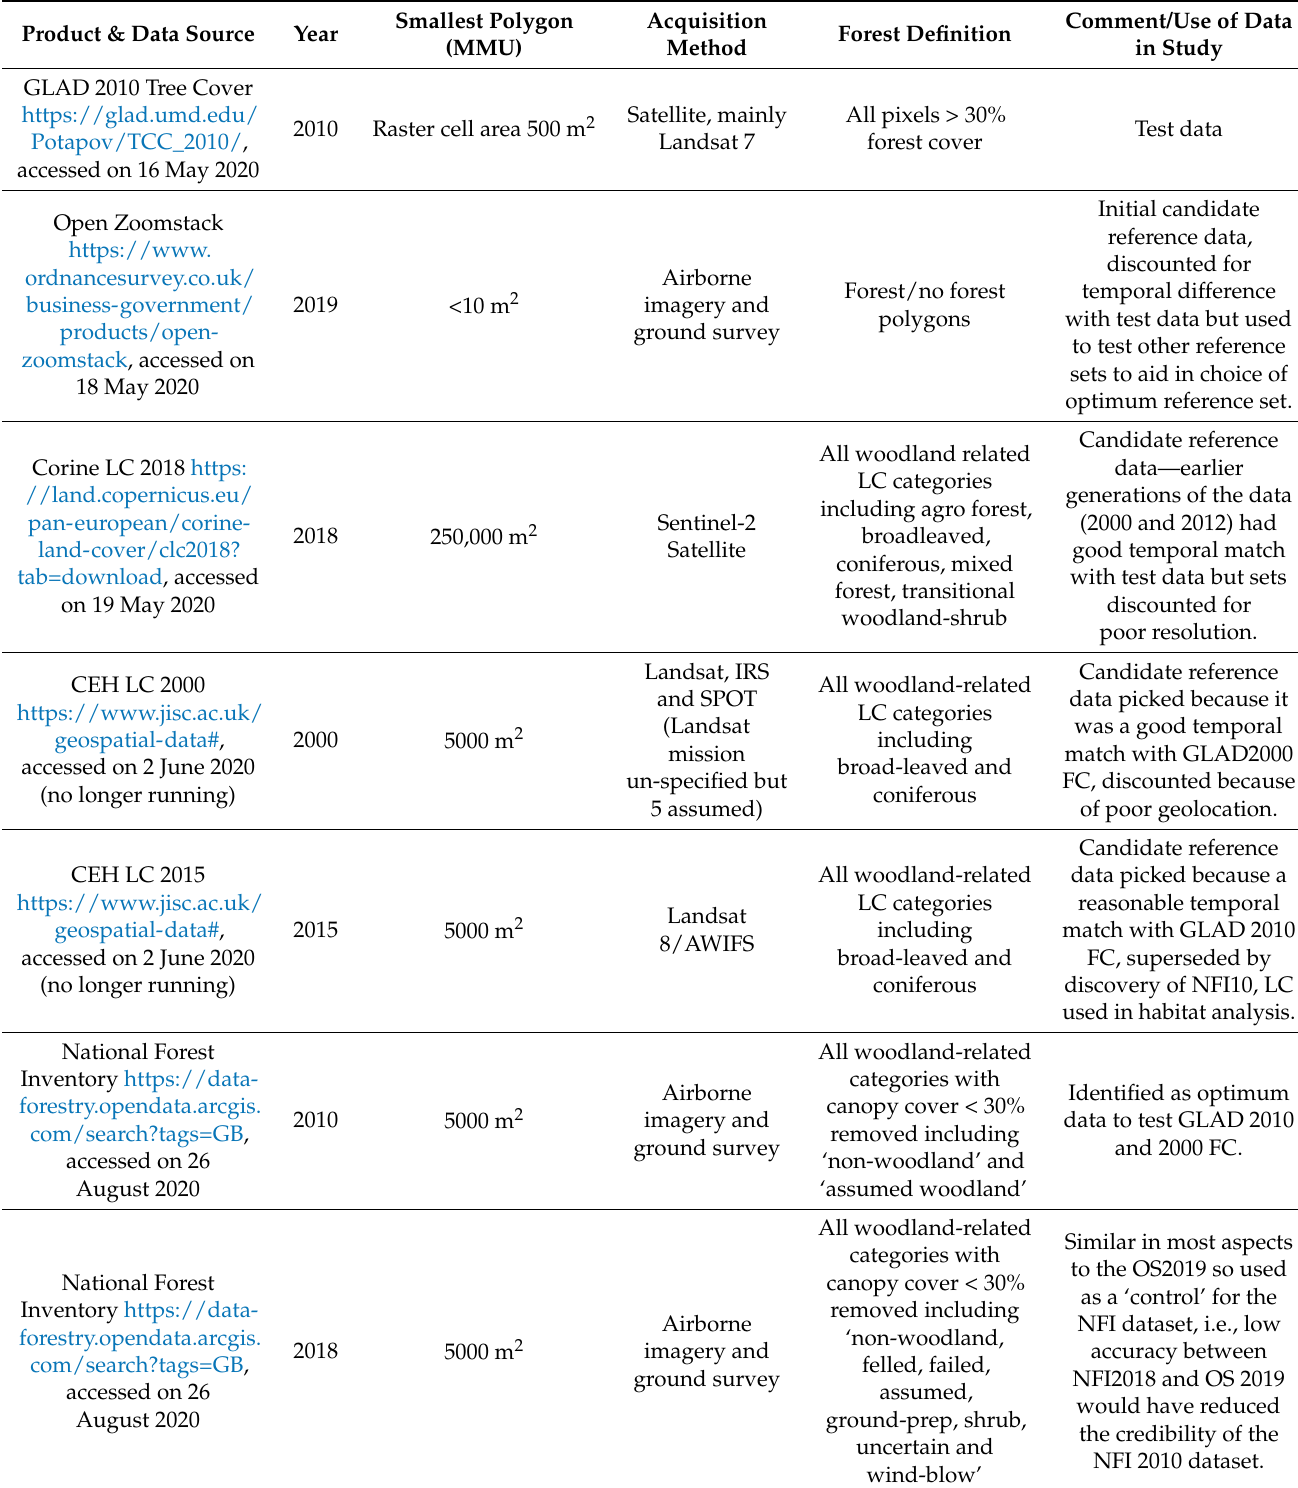
Table 1. Forest cover datasets used in this research